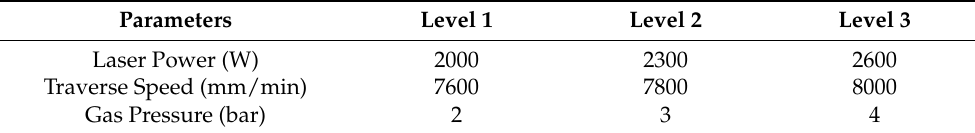
Table 3. Input parameters levels for specimen thickness of 6 mm, in laser beam cutting process.